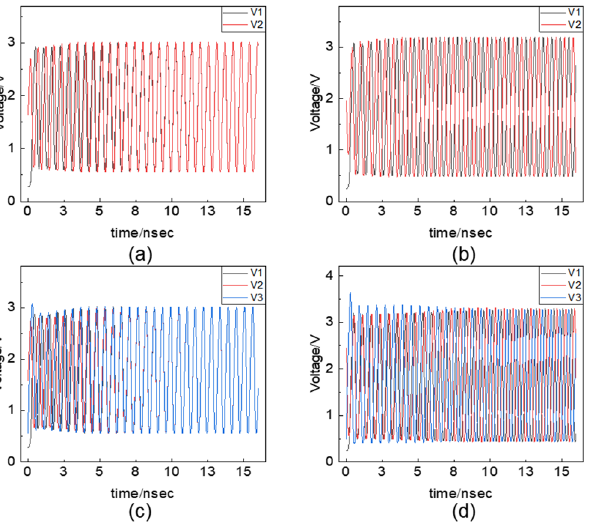
Figure 8. Phase diagram of ( a ) 2 positively coupled oscillators; ( b ) 2 negatively coupled oscillators; ( c ) 3 positively coupled oscillators; ( d ) 3 negatively coupled oscillators. When the oscillator is subjected to an external perturbation signal of about twice the 2 f f ≈ ), the generalized SHIL Adler’s equation is [34] base frequency ( 1 0